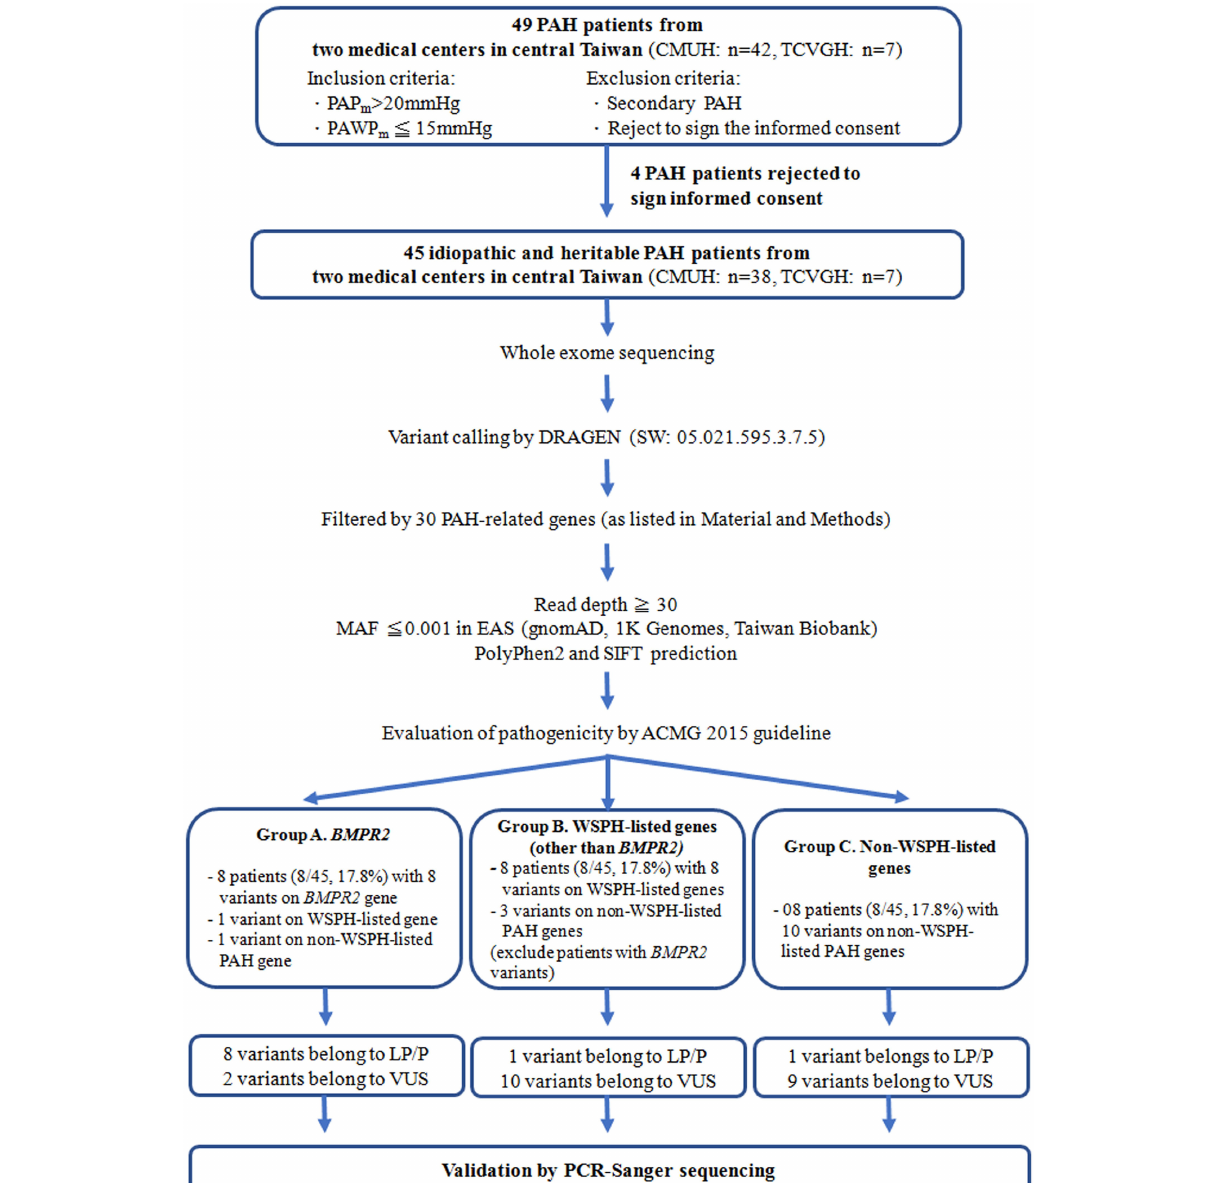
techniques (21). The date of 1st right heart catheterization was deemed as the time of initial PAH